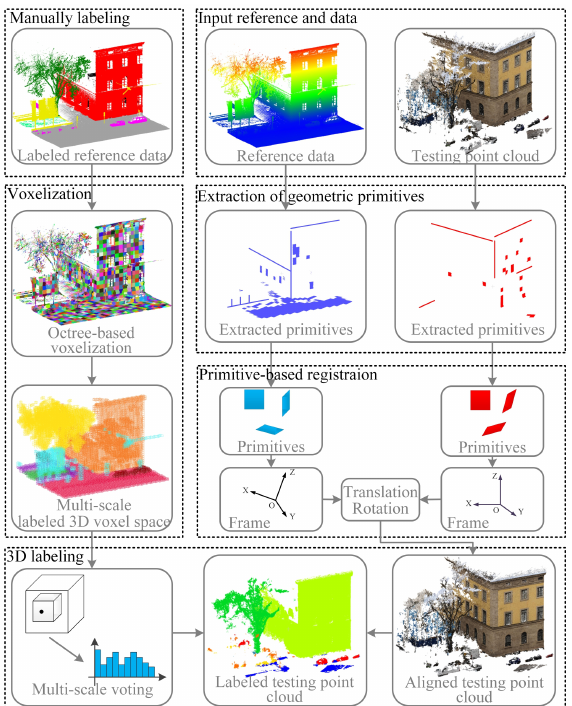
Figure 2. Workflow of generating new labeled point cloud by using labeled 3D space.